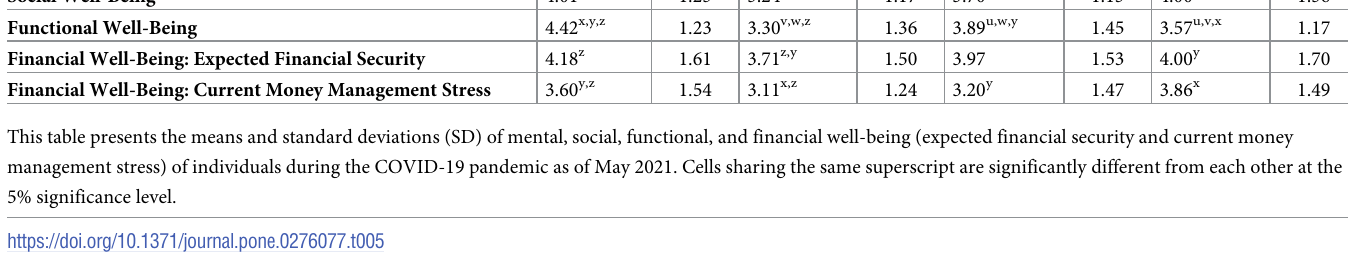
This table presents the means and standard deviations (SD) of mental, social, functional, and financial well-being (expected financial security and current money management stress) of individuals during the COVID-19 pandemic as of May 2021. Cells sharing the same superscript are significantly different from each other at the 5% significance